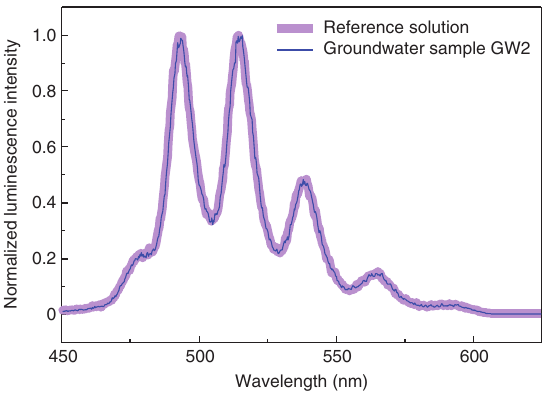
Figure 4 Bold and thin lines represent the normalized luminescence spectra of the reference solution [U(VI) concentration of 5 μ g/l in a mixed sulfate solution of 0.074 m K GW2 groundwater sample pretreated with K